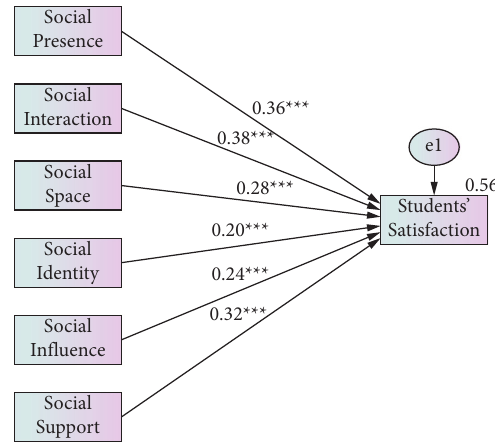
Figure 3: Path coefficient analysis of proposed hypotheses. Table 7: Results for the testing hypotheses of structural